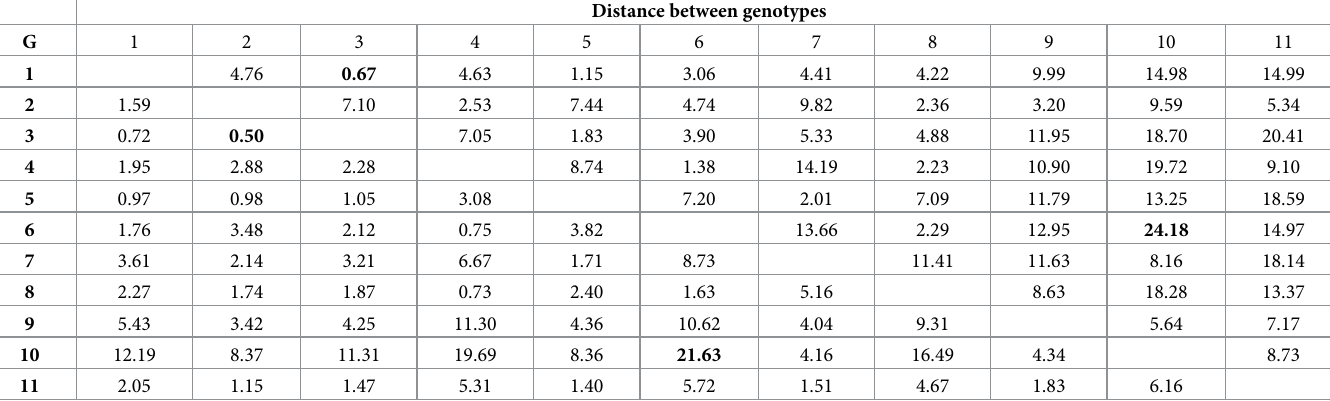
Table 9. Genetic divergence among 11 sugarcane genotypes based on eight agro-industrial traits evaluated over two consecutive years during the final phases of tri- als conducted in sugarcane microregions in the State of Pernambuco.